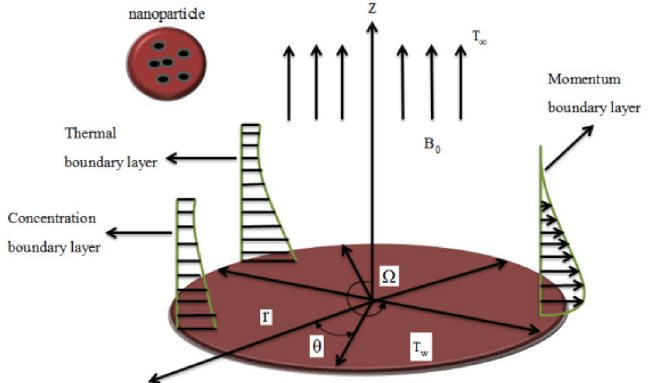
Figure 1. Physical flow